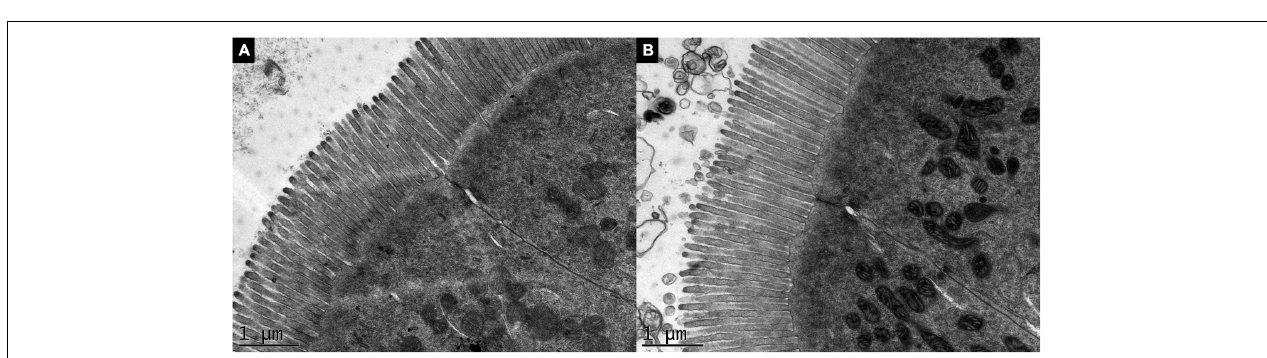
FIGURE 5 | Ultrastructure of the intestinal microvilli of gh -transgenic zebrafish ( D. rerio ). Electron micrographs show organized microvilli on the apical surface in the enterocyte of non-transgenic (A) and gh -transgenic zebrafish (B) siblings. No difference in surface area of microvillus from the anterior intestine was detected between the groups ( p > 0.05). Magnification: × 25.000, scale bar: 1 µ